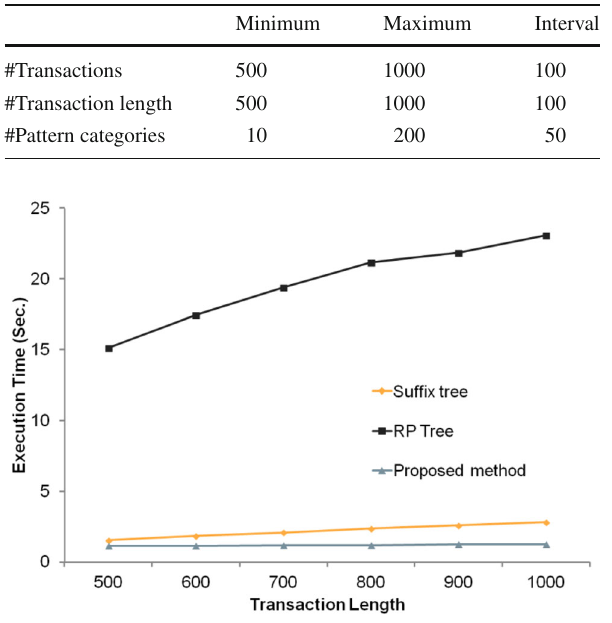
Fig.12 Execution time of the compared methods under different trans- action lengths